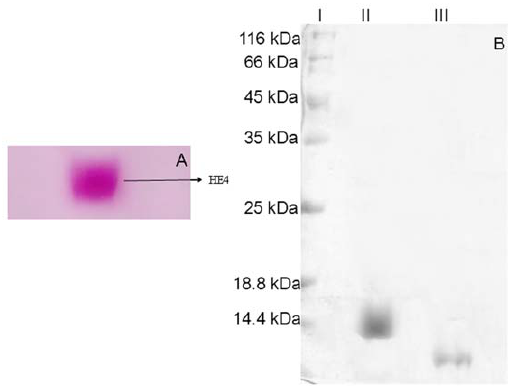
Figure 2. Glycosylation analysis of HE-4. ( A ) PAS staining of HE-4 protein. ( B ) 12.5% SDS-PAGE of glycolsylated and unglycosylated form of HE-4 Lane I: Protein marker. Lane II: Glycosylated HE-4. Lane III: Unglycosylated HE-4.